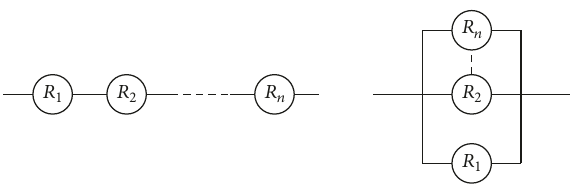
Figure 1: Series system and parallel